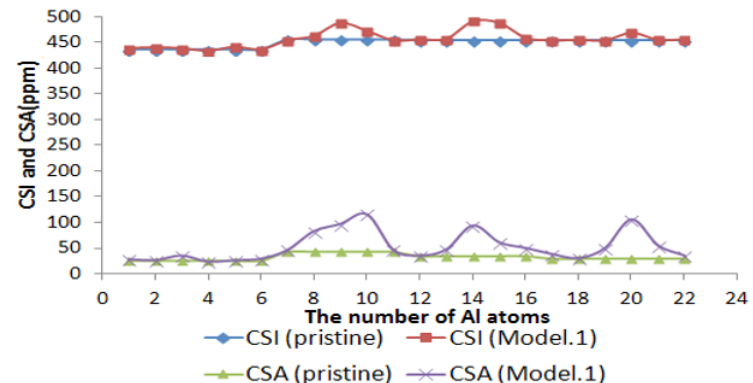
Figure 8. The NMR parameters for the 27 Al atoms of O-decorated (10, 0) zigzag AlNNT (Model.1).